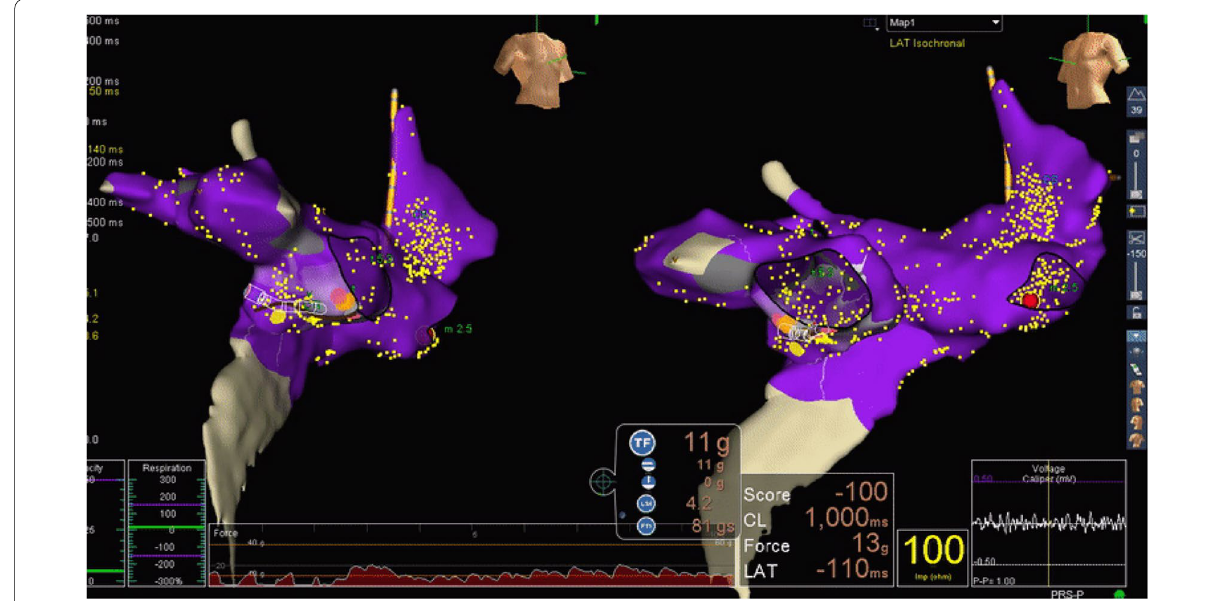
Fig. 1 The right anterior oblique view-the left image- and the left anterior oblique view -the right image- are demonstrating the macrorentry AA that is propagating around the right-sided atrioventricular valve annulus (morphologic tricuspid valve) in a counter-clockwise fashion. The patient had history of D-transposition of great arteries status post Mustard procedure and superior vena cava stenosis requiring